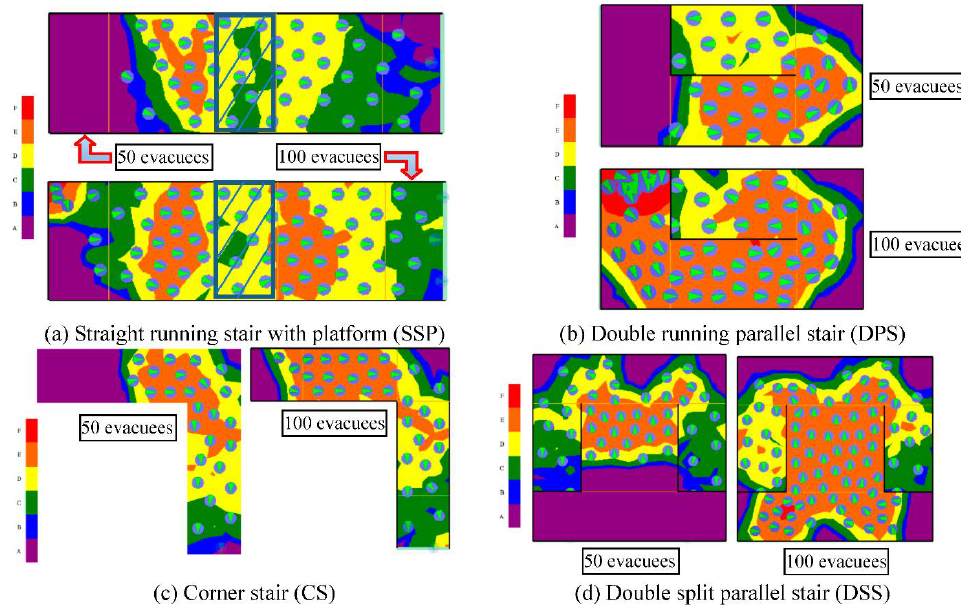
Figure 9. Crowd density distribution in staircases.